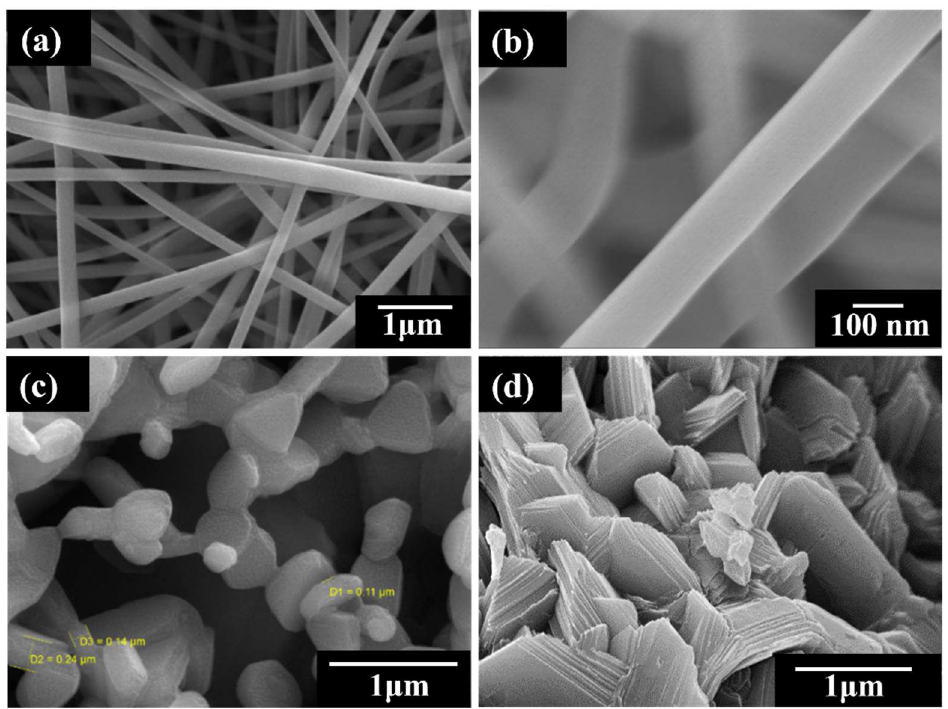
Figure 1. Schematic illustration of the synthesis of the NaCM -iB cathode material.